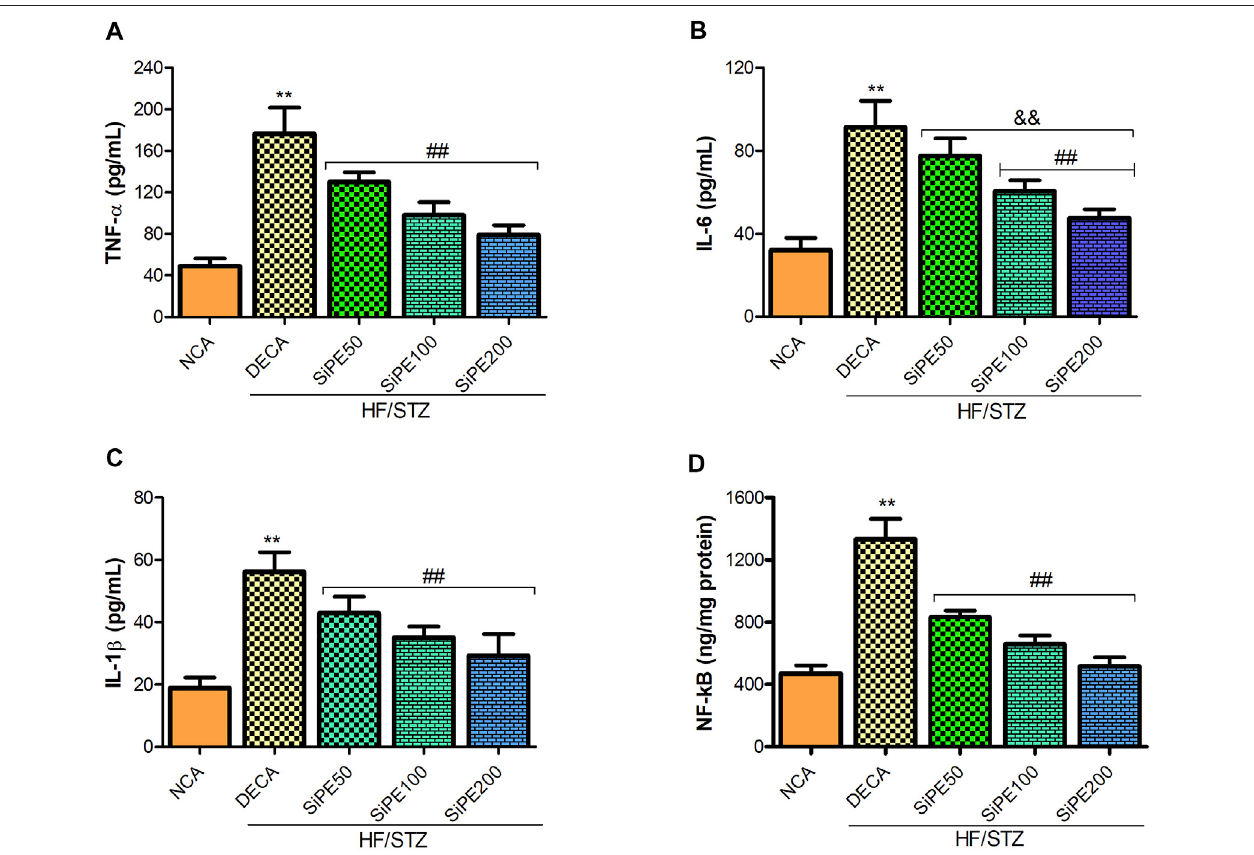
FIGURE 7 | Effect of SiPE treatment on in fl ammatory mediators in HF/STZ-induced diabetic encephalopathic rats. SiPE treatment at doses of 50, 100 or 200 mg/kg caused signi fi cant decrease in (A) brain tumor necrosis factor alpha (TNF- α ), (B) interleukin 6 (IL-6), (C) interleukin one beta (IL-1 β ) and (D) nuclear factor kappa-light-chain-enhancer of activated B (NF- κ B) compared to DECA group. Data are presented as mean ± SD ( n (cid:2) 5 – 6) and one-way ANOVA test was applied. ** p < 0.001indicatesstatisticalsigni fi cancecomparedtoNCAgroup.## p < 0.001,&& p < 0.01and$$ p < 0.05indicatestatisticalsigni fi cancecomparedtoDECAgroup.